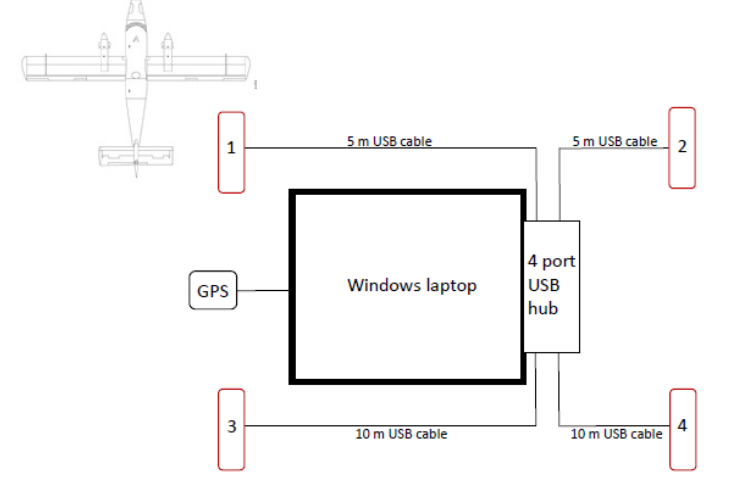
Figure 9. Geometer setup for four observers on board a de Havilland Twin Otter used for aerial surveys in Greenland. Numbers refer to Geometers